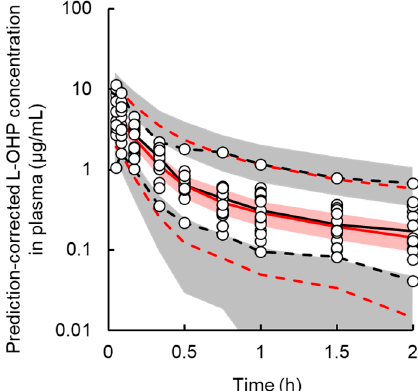
Figure 2. Prediction-corrected visual predictive check plot for the final pharmacokinetic model of oxaliplatin (L-OHP) in rats. The solid black and red line represents the median observed and simulated prediction-corrected plasma concentration, respectively, and the semitransparent red field represents a simulation-based 95% confidence interval for the median. The observed and simulated 5% and 95% percentiles are presented with dashed black and red lines, respectively, and the 95% confidence intervals for the corresponding model predicted percentiles are shown as semitransparent gray fields. The observed prediction-corrected plasma concentrations are represented by circles.